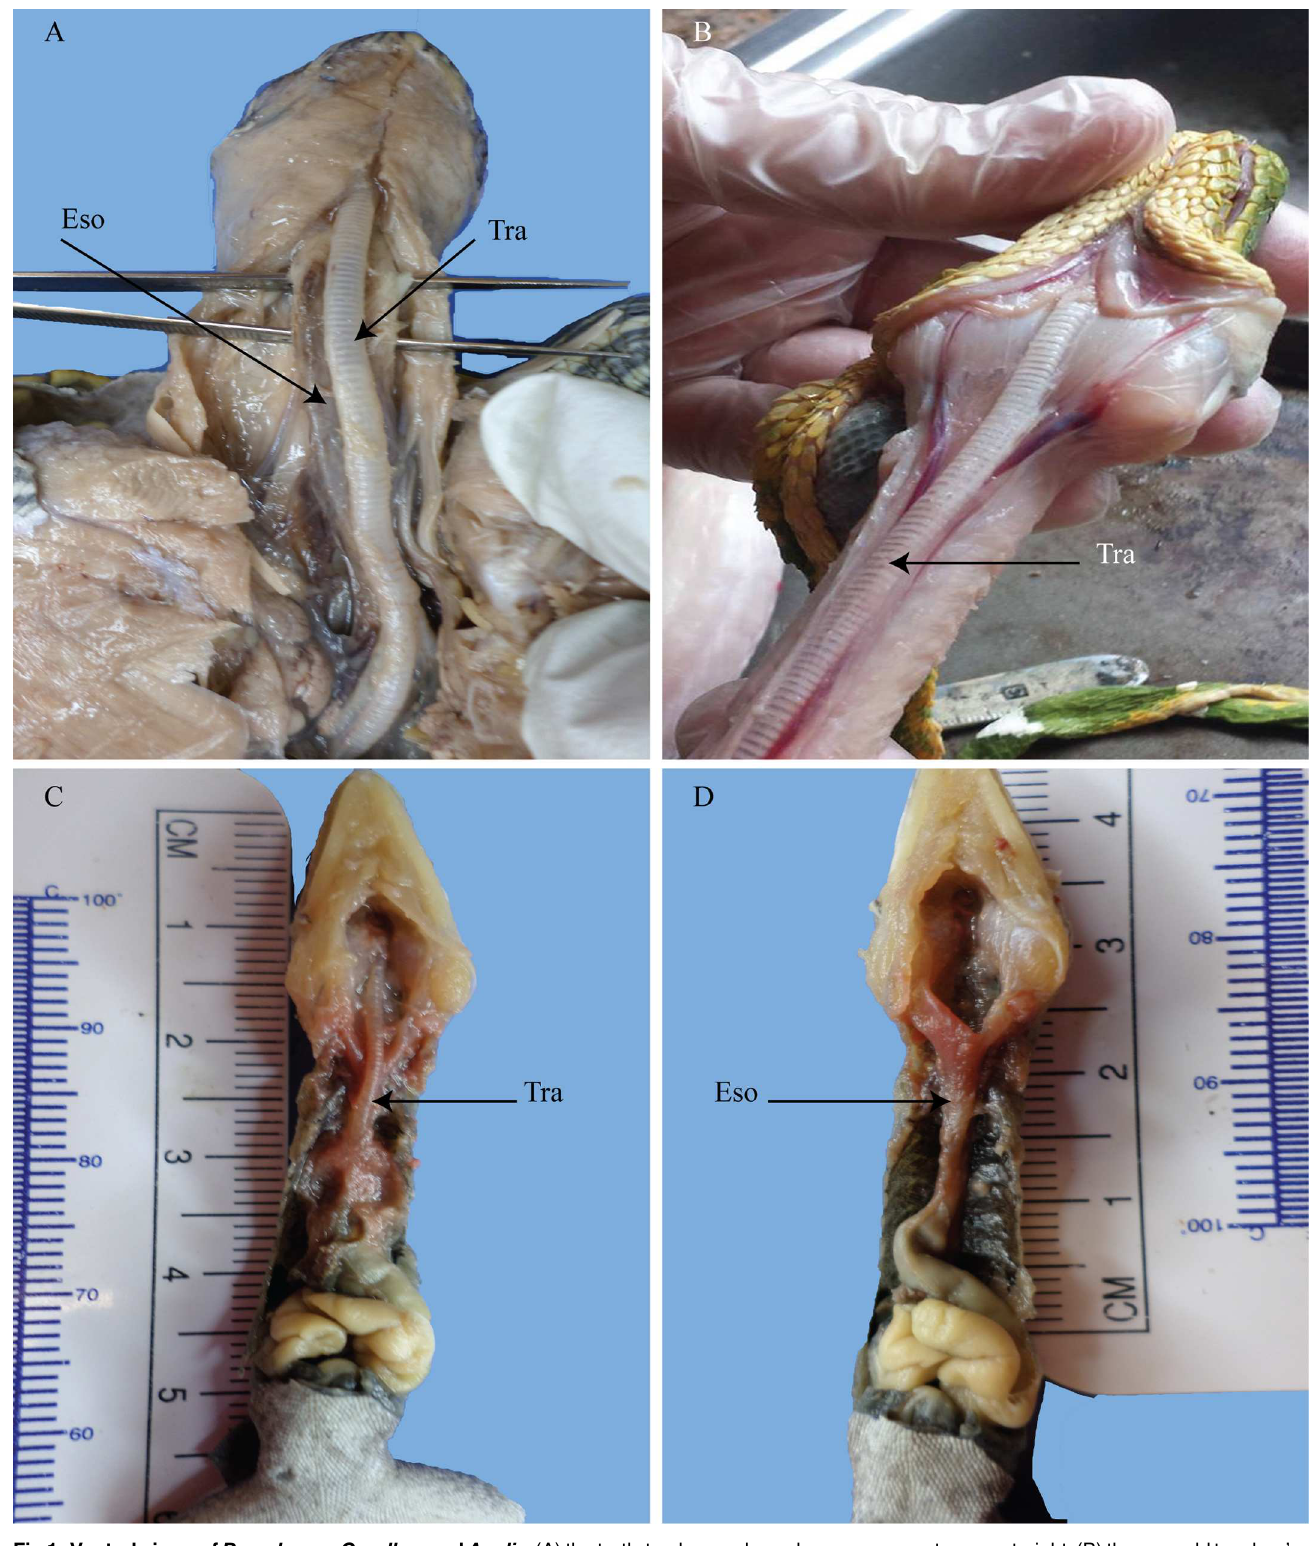
Fig 1. Ventral views of Pseudemys , Corallus ,and Anolis . (A) the turtletracheaand esophagusare seen to pass straight. (B) the emeraldtree boa’s trachea and esophagus are seen to stay in the midline.(C) the anolis trachea’s course is straight. (D) the anolis esophagus passes midsagittally. Tra = trachea;Eso = esophagus. Emeraldtree boa imagecourtesyof R. DePalma. doi:10.1371/journal.pone.0163348.g001 PLOS ONE | DOI:10.1371/journal.pone.0163348 September20,